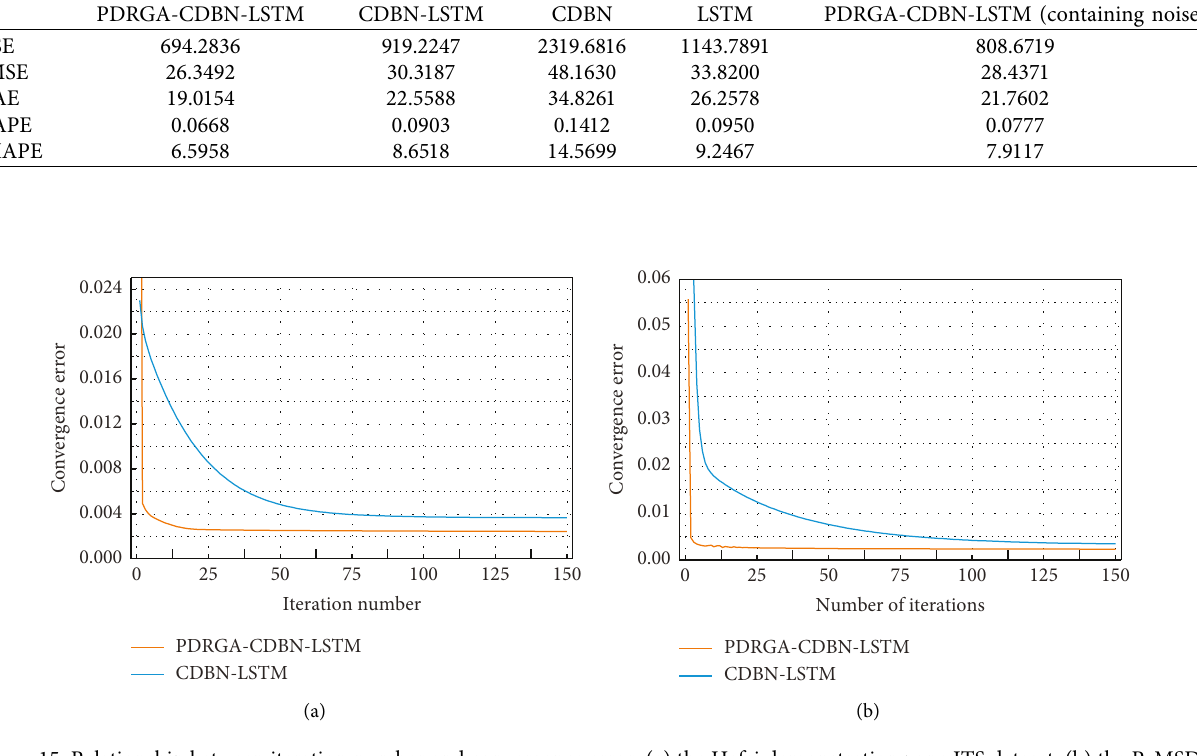
Figure 15: Relationship between iteration number and convergence error: (a) the Hefei demonstration zone ITS dataset; (b) the PeMSD8